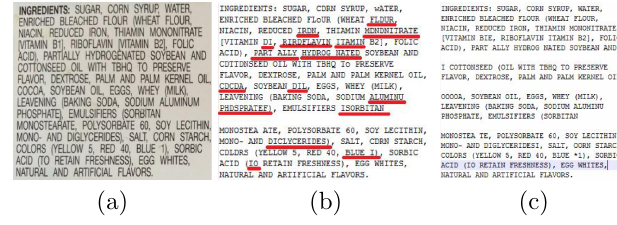
Figure 8. Recognition accuracy improved with use of approximate matching with the ingredient list. (a) Original food label, (b) result directly from OCR, (c) result tidied up.